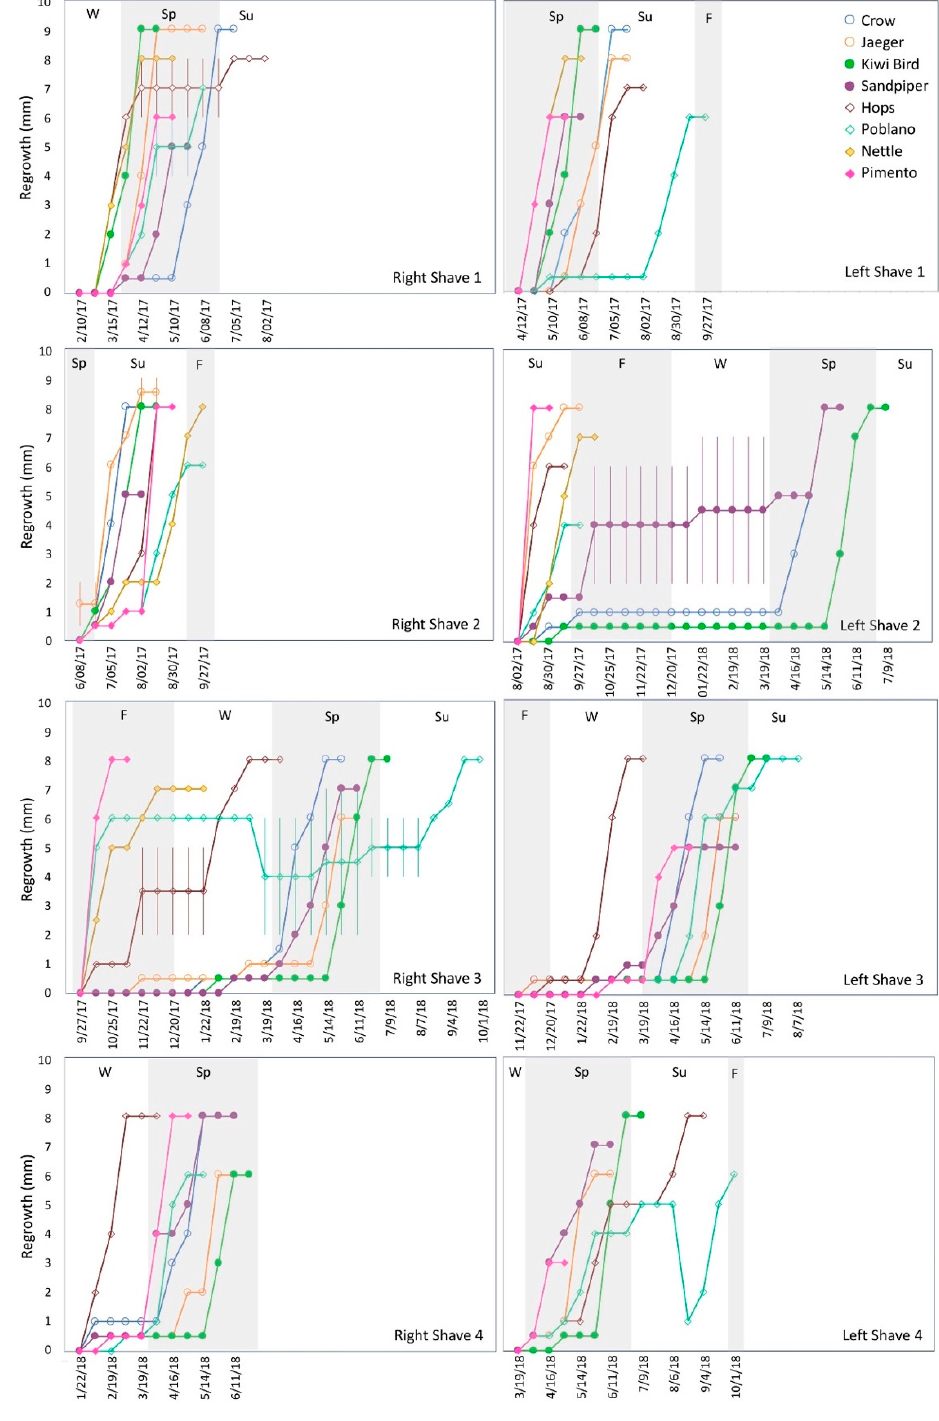
Figure 2. Fur regrowth for each shave and individual. Dwarf lemurs are circles and mouse lemurs are diamonds. Males are open symbols; females are filled. Error bars represent the range of length measurements for patchy regrowth (Supplementary Table S4). Shaded areas delineate different seasons (W = Winter; Sp = Spring; Su = Summer; F = Fall). No data are available for Nettle’s LS3, RS4, or LS4.